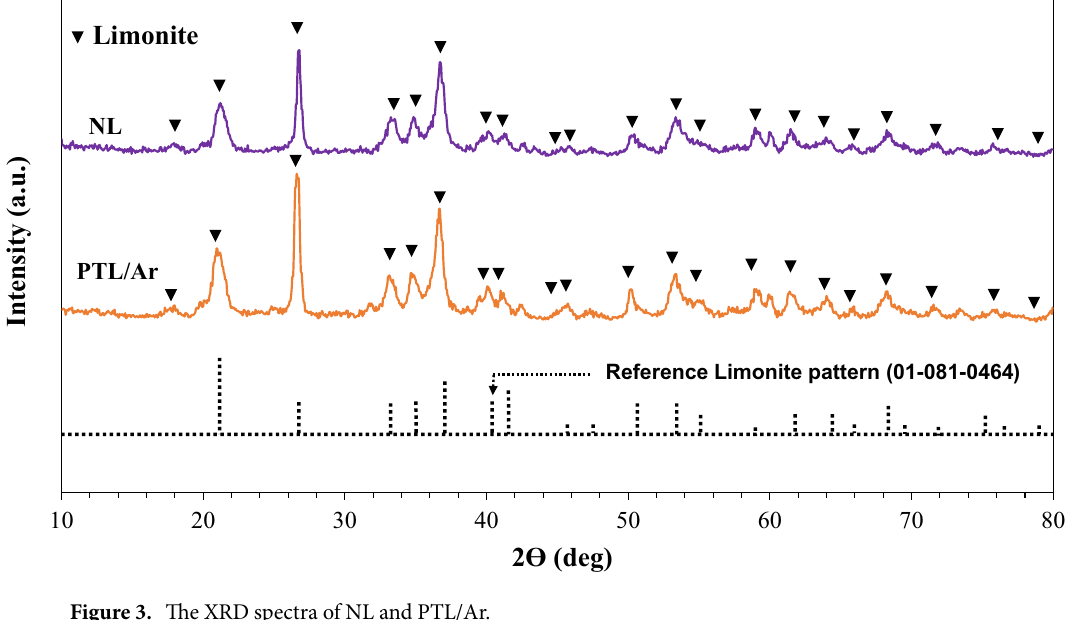
Figure 3. The XRD spectra of NL and